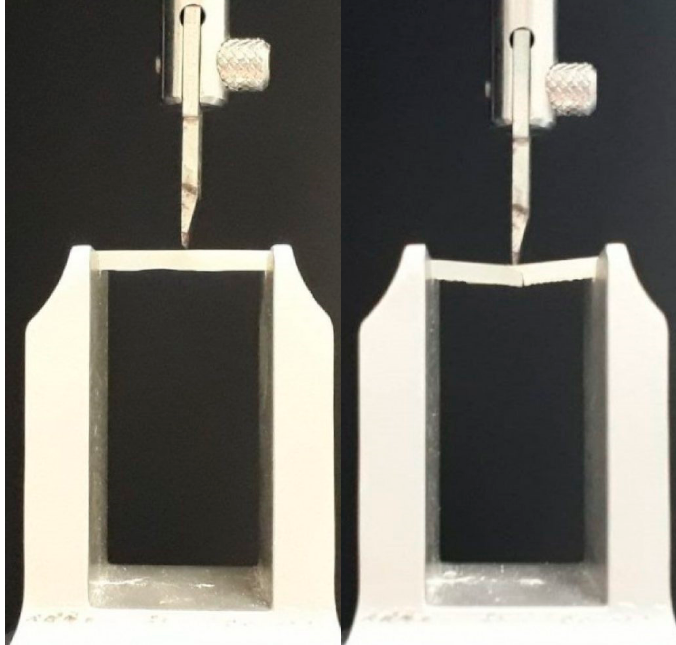
Figure 1. Mechanical tests performed on the samples (span length: 21mm): left, sample before the fracture; right, sample at the moment of the fracture.